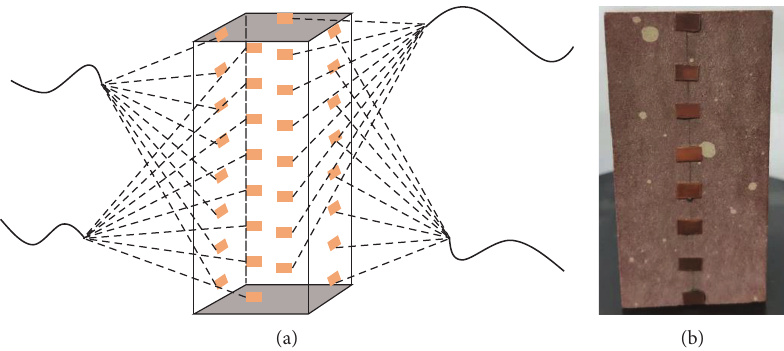
Figure 4: Distribution of electrodes. (a) Electrode distribution diagram (b) Physical picture of electrode distribution. Table 2: Ultrasonic vibration generation experimental program. Specimen number